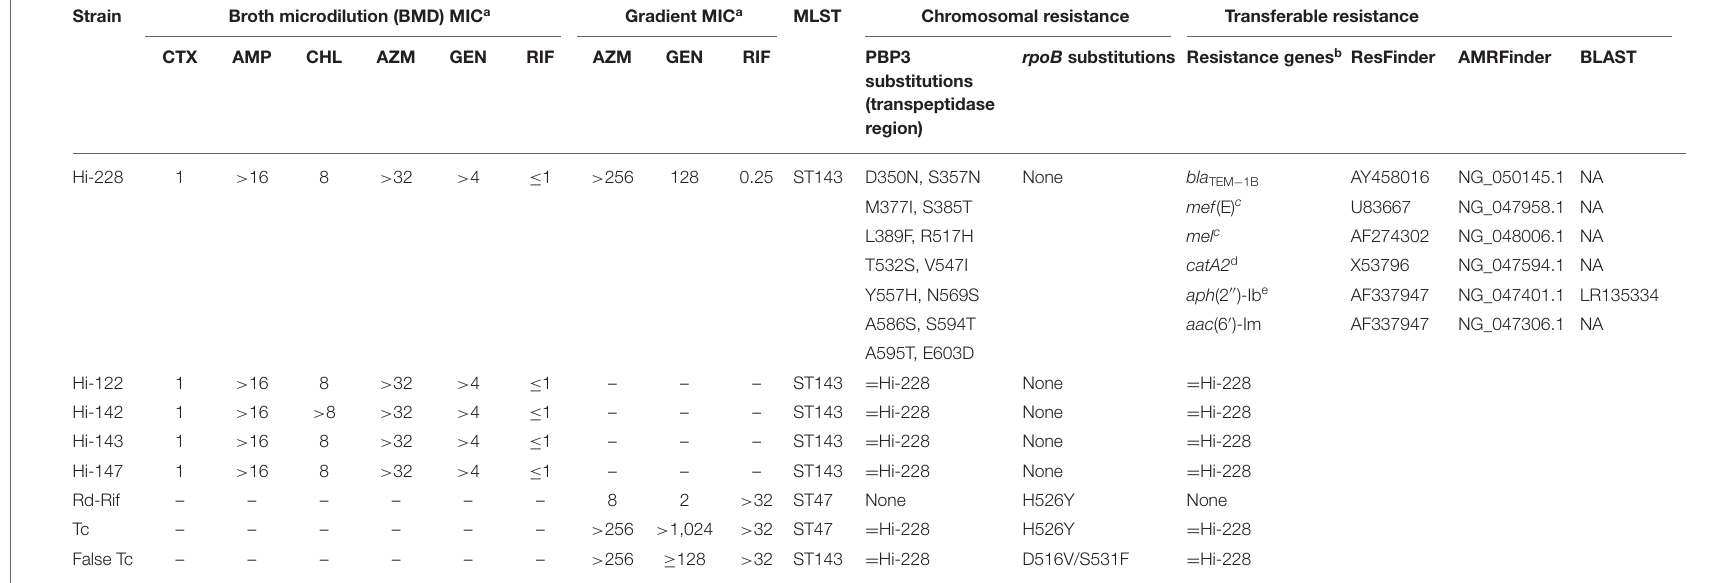
TABLE 1 | Characteristics of Hi-228, Hi-122, Hi-142, Hi-143, Hi-147, recipient strain (Rd-Rif), true transconjugants (Tc), and false transconjugants